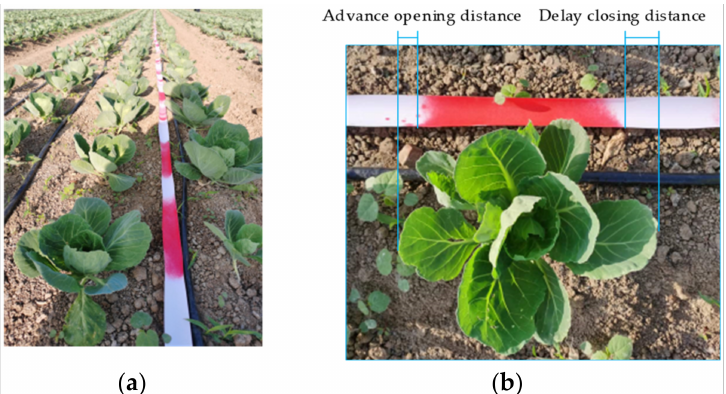
Figure 9. Arrangement of the color-changing filter paper and measurement of the target error. ( a ) Diagram of color-changing filter paper layout. ( b ) Diagram of target error measurement.